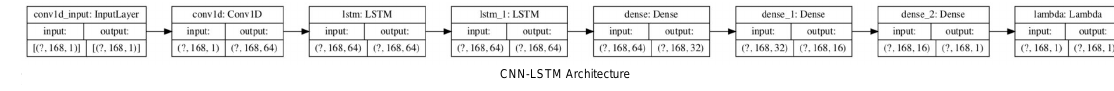
Figure 9. The architecture of the CNN-LSTM hybrid